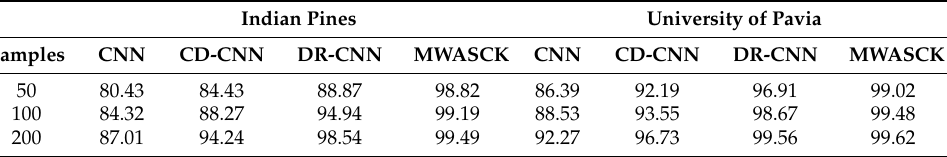
Table 4. Overall accuracy (OA) values of different methods under different training samples on two